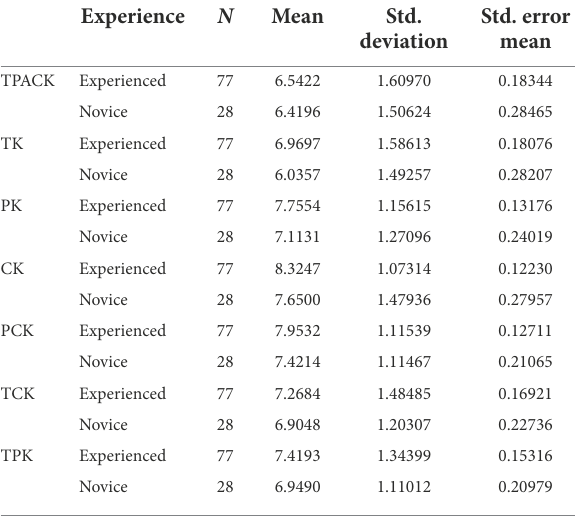
TABLE 4 Mean difference of experienced and novice teachers’ TPACK.